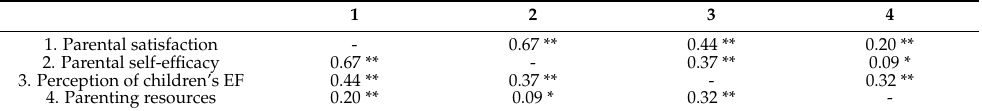
Table 5. Correlations among parental satisfaction, parental self-efficacy, parents’ perception of children’s EF, and parenting